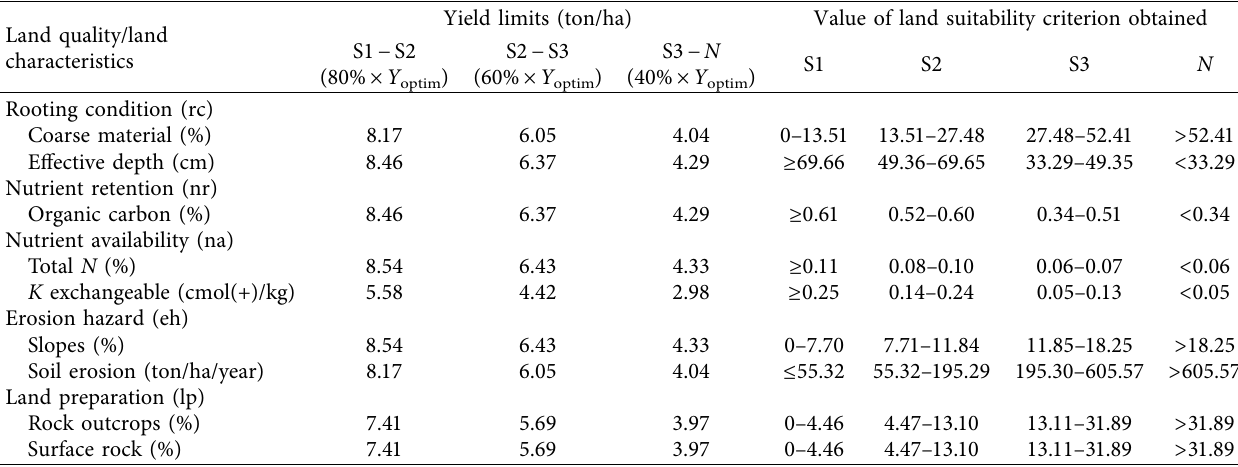
Table 8: Yield limits of hybrid maize and values obtained in each land suitability class interval by land quality and characteristics. Land quality/land characteristics